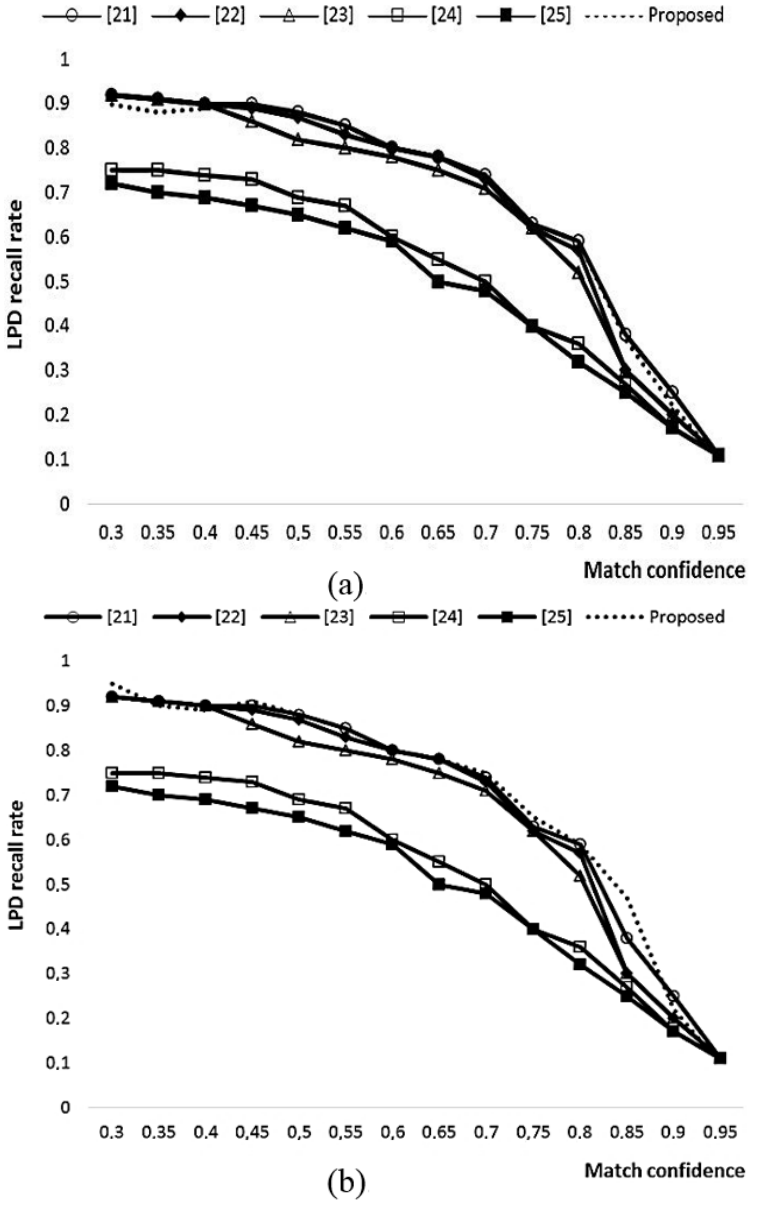
Figure 4. ( a ) Precision and ( b ) recall